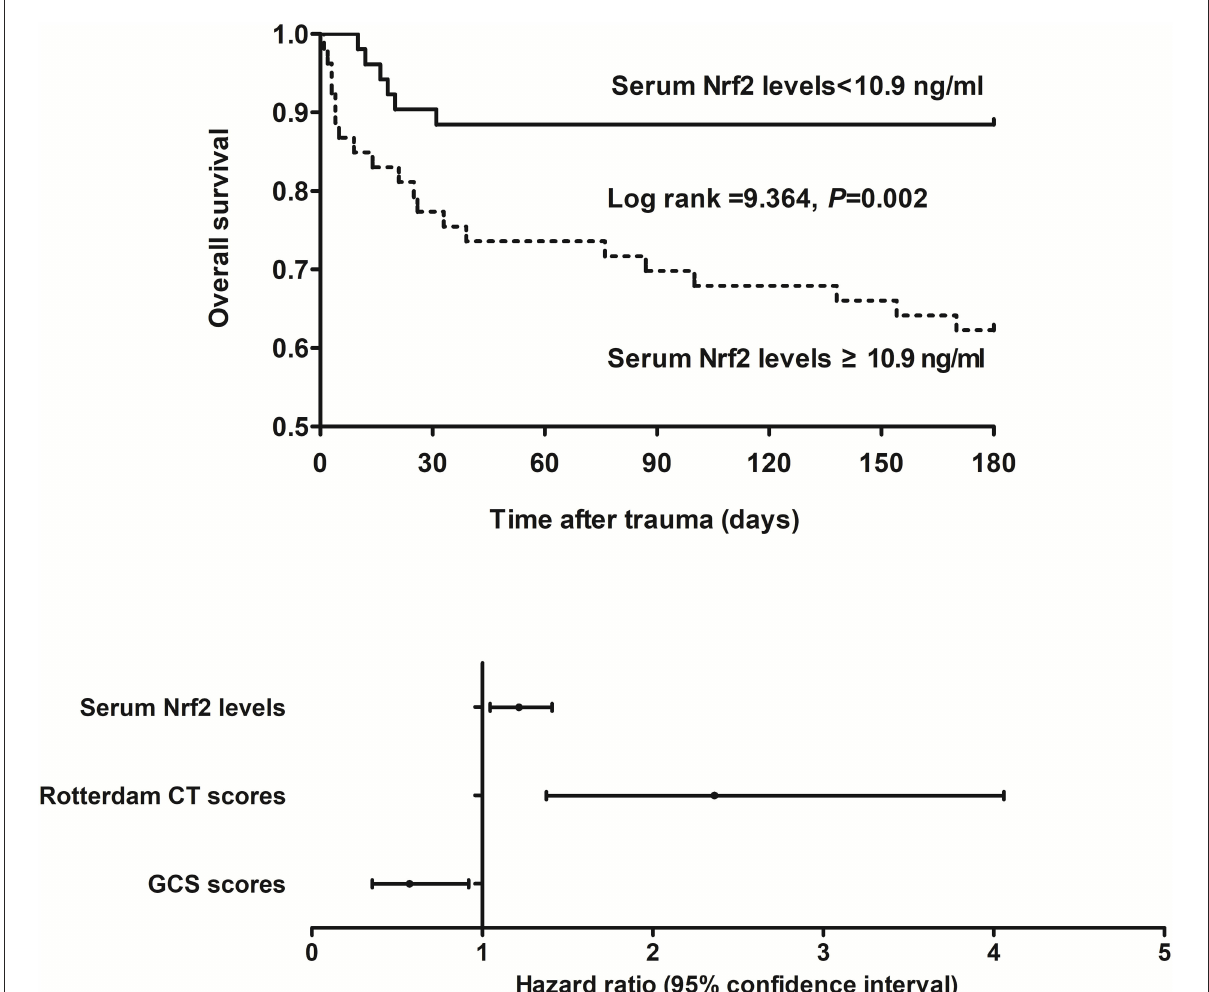
FIGURE5 Relationship between serum nuclear factor erythroid 2-related factor 2 levels and 180-day overall survival after severe traumatic brain injury. Serum nuclear factor erythroid 2-related factor 2 levels, Rotterdam computed tomography scores, and Glasgow Coma Scale scores were independently associated with 180-day overall survival after severe traumatic brain injury (all P < 0.05). Patients with serum nuclear factor erythroid 2-related factor 2 levels ≥ 10.9ng/ml (median value) displayed substantially shorter 180-day overall survival time than the other remainders ( P < 0.01). Nrf2 indicates nuclear factor erythroid 2-related factor 2; CT, computed tomography; GCS, Glasgow Coma